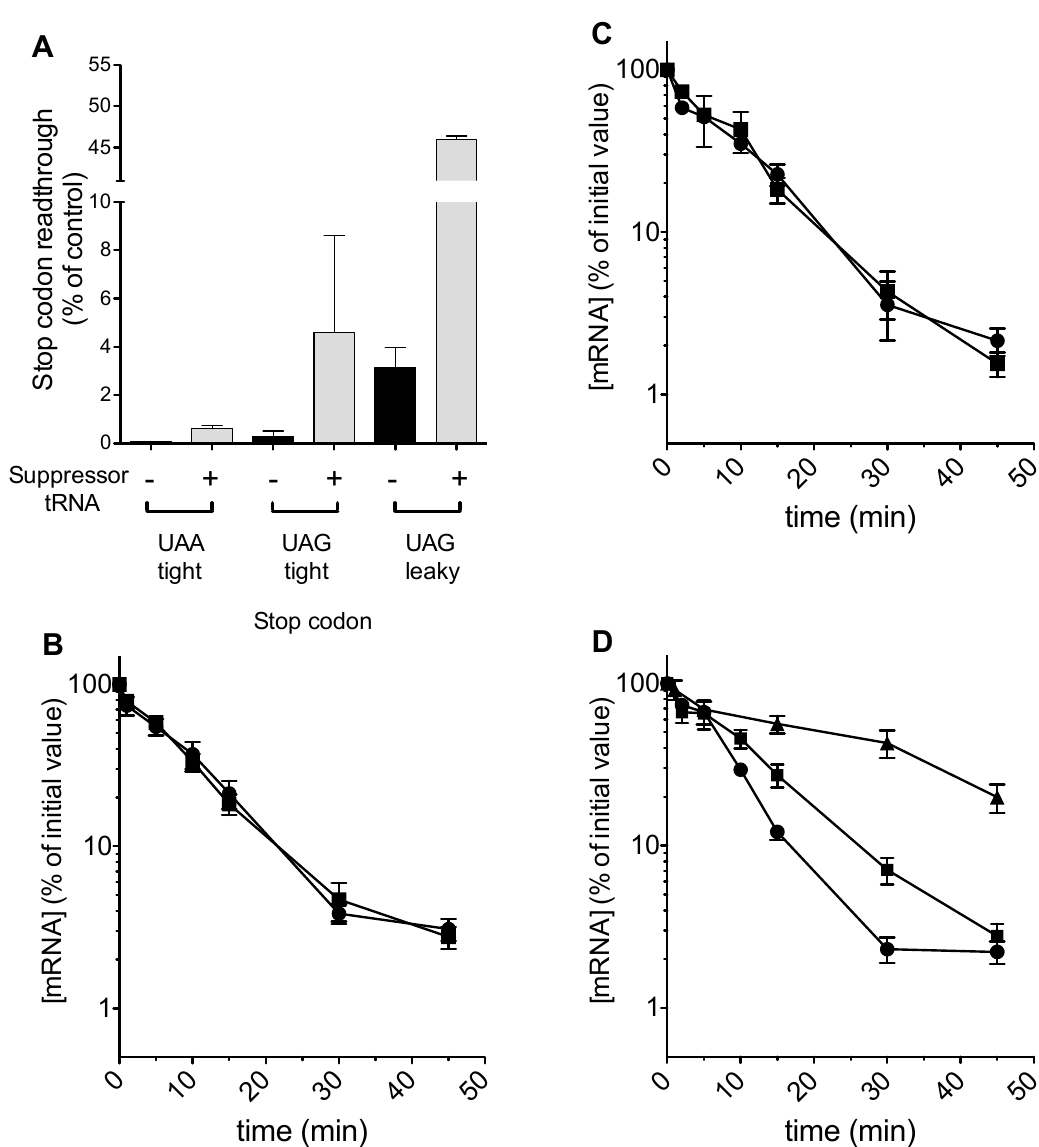
Figure 3. Stop codon readthrough is insu ffi cient to restore stability to the C22 early premature